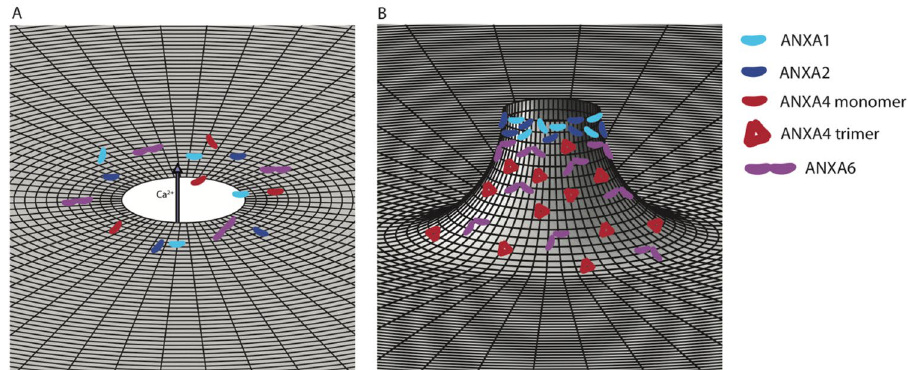
Figure 6. Schematic representation of PMR mediated by ANXA1, ANXA2, ANXA4 and ANXA6 action. In uninjured cells, annexins are distributed uniformly as monomers in the cytoplasm. Upon local plasma membrane injury, Ca 2+ influx ( A ) results in recruitment of annexins to the membrane wound edges ( B ). ANXA1 and ANXA2 preferentially bind to free membrane edges (light and dark blue respectively, B ) positioning them as sites of recruitment for binding partners involved in repair processes and for crosslinking to adjacent membranes such as intracellular vesicles that arrive at the damage site as membrane resupply. Binding as trimers, ANXA4 induces out of plane curvature (red, B ), mixing with ANXA6 which provides constriction force to the membrane (purple, B ) and is available to bind to sources of membrane